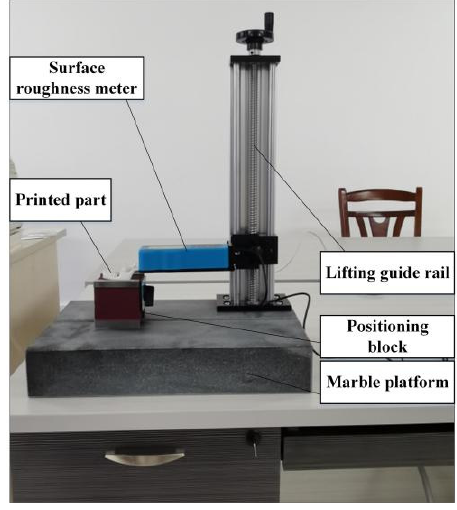
Figure 9. Platform of the surface roughness meter. Table 2. Measured surface roughness of the lower teeth.